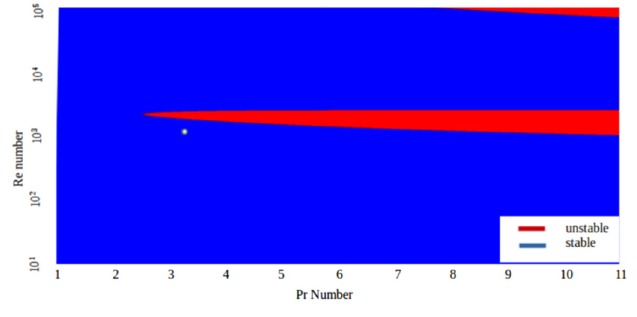
Fig. 15. Stability